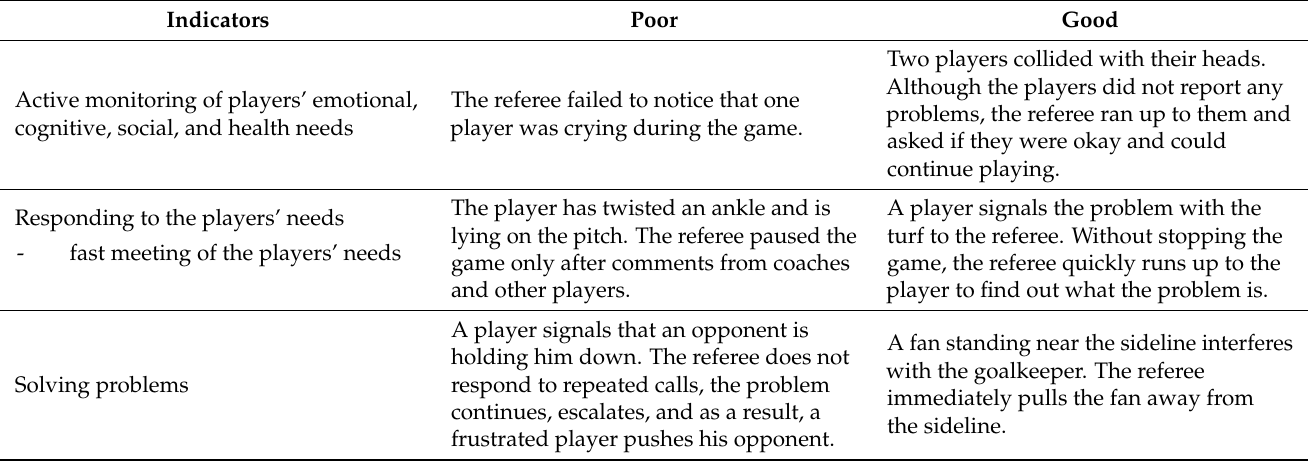
Table 3. Examples of low- and high-quality interactions in referee’s responsiveness to players’ needs .